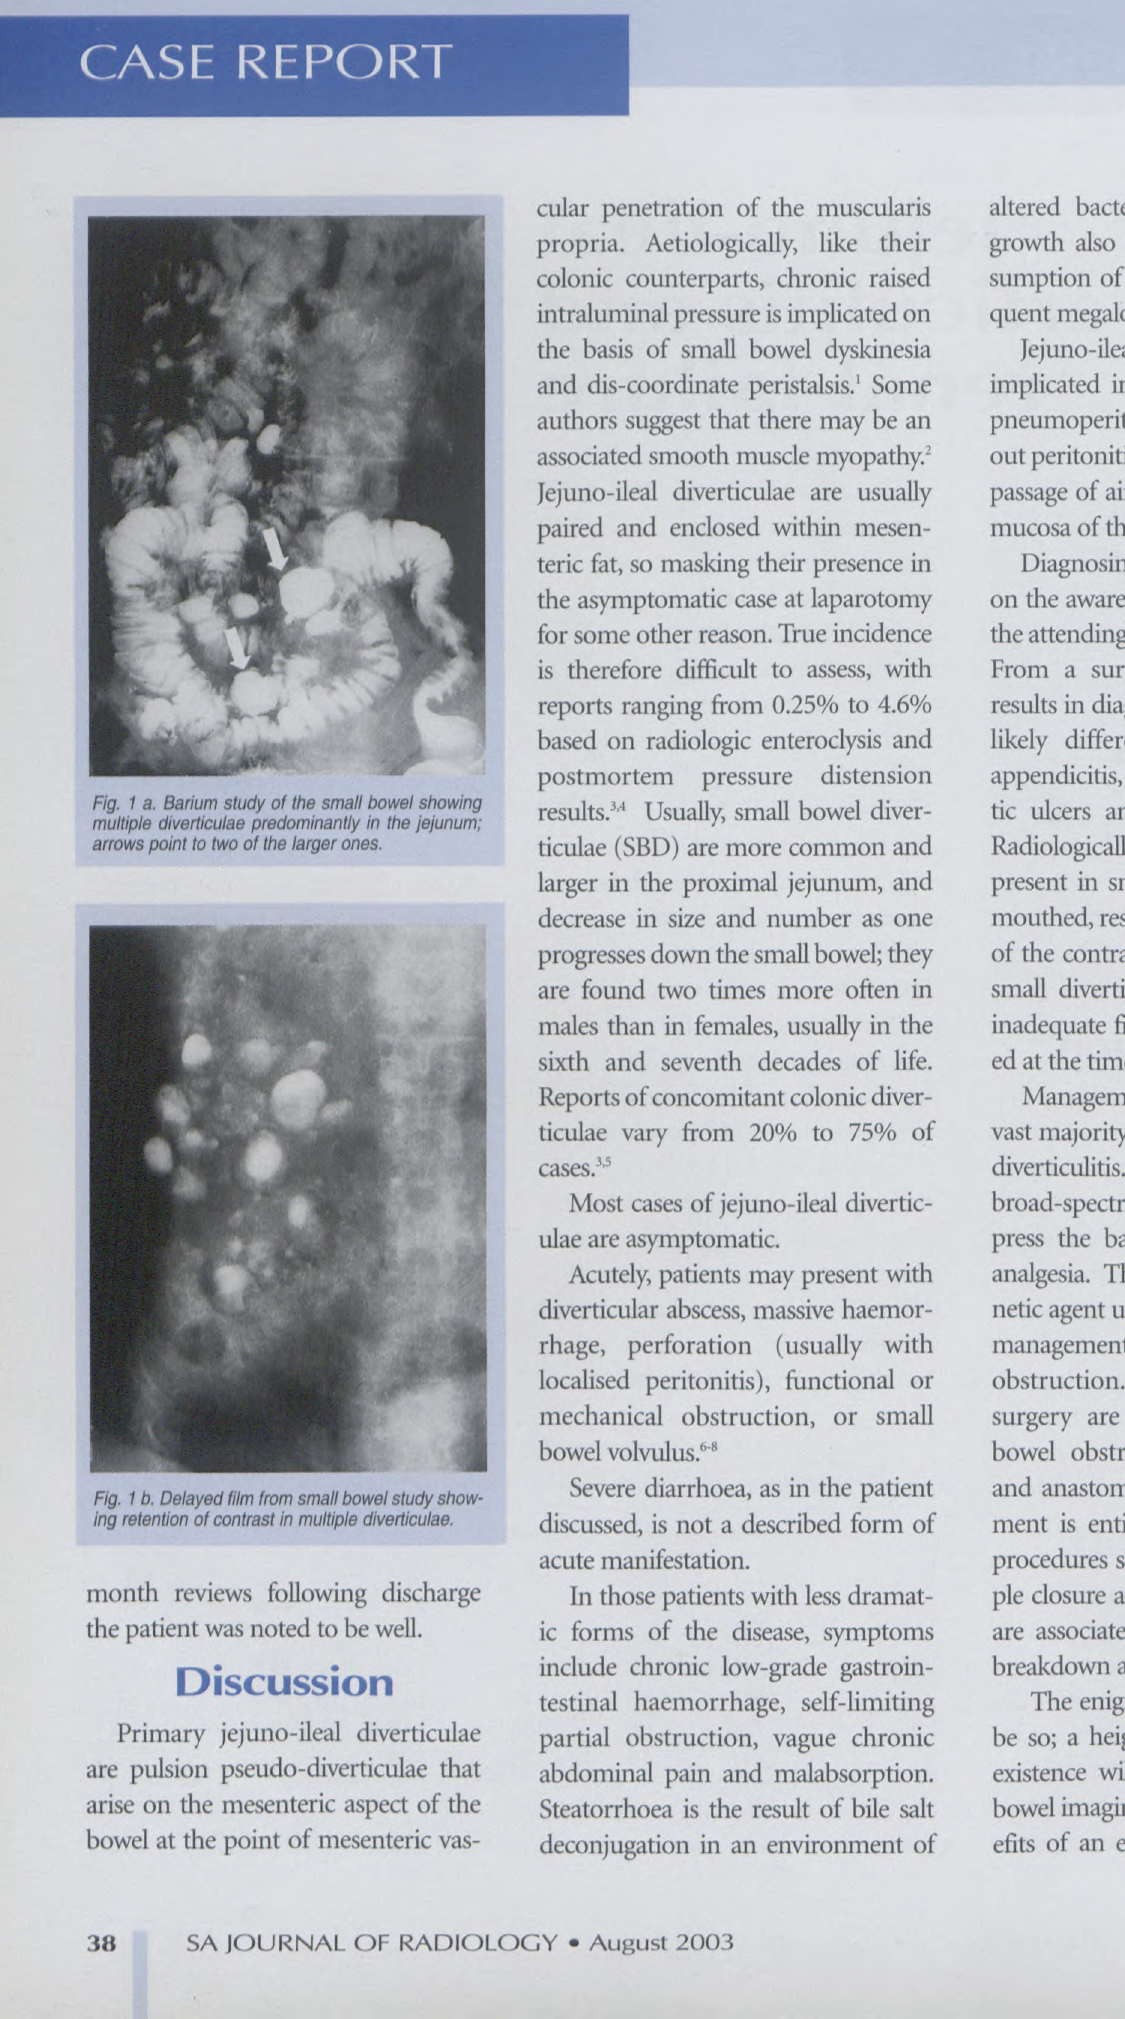
Fig. 1 b. Delayed film from small bowel study show· ing retention of contrast in multiple